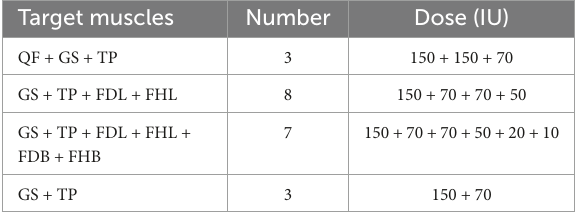
QF, quadriceps femoris; GS, gastrocnemius; TP, tibialis posterior; FHL, flexor hallucis longus; FDL, flexor digitorum longus; FDB, flexor digitorum brevis; FHB, flexor